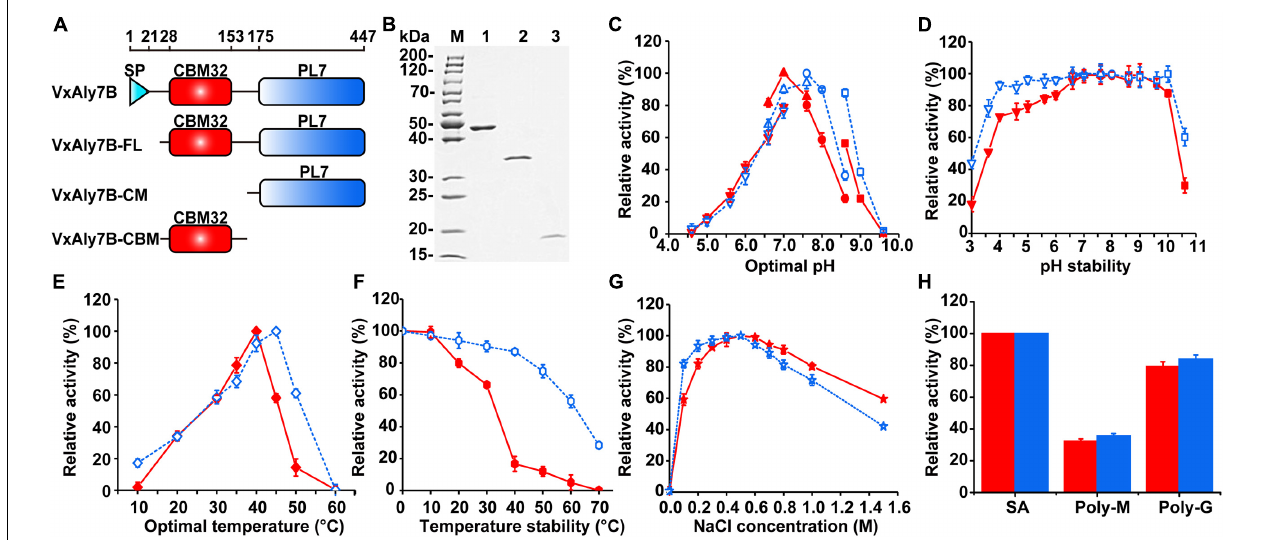
FIGURE 2 | Purification and enzymatic characteristics of recombinant VxAly7B and its truncated mutants. (A) Domain structure of full long VxAly7B and its two truncated mutants. (B) Purified recombinant VxAly7B-FL, VxAly7B-CM, and VxAly7B-CBM were resolved by SDS-PAGE. Lane M, molecular weight markers; Lane 1, purified recombinant VxAly7B-FL; Lane 2, recombinant VxAly7B-CM; Lane 3, recombinant VxAly7B-CBM. (C) Optimum pH for recombinant VxAly7B-FL and VxAly7B-CM were determined by measuring the activity at 40 or 45 ◦ C in 50 mM Na 2 HPO 4 -citric acid buffer (pH 4.6–7.0, inverted triangles), 50 mM Na 2 HPO 4 -NaH 2 PO 4 buffer (pH 6.6–7.6, regular triangles), 50 mM Tris-HCl buffer (pH 7.6–8.6, circles) and 50 mM Gly-NaOH buffer (pH 8.6–9.6, squares). The red line represented the recombinant VxAly7B-FL, and the blue line represented the recombinant VxAly7B-CM. (D) To determine pH stability, the residual activity of recombinant VxAly7B-FL and VxAly7B-CM were measured at 40 or 45 ◦ C in 20 mM Na 2 HPO 4 -NaH 2 PO 4 buffer (pH 7.0) and Tris-HCl buffer (pH 7.6) after incubation in 50 mM Na 2 HPO 4 -citric acid buffer (pH 3.0–7.0, inverted triangles), 50 mM Na 2 HPO 4 -NaH 2 PO 4 buffer (pH 6.6–7.3, regular triangles), 50 mM Tris-HCl buffer (pH 7.6–8.6, circles) and 50 mM Gly-NaOH buffer (pH 8.6–10.6, squares) at 4 ◦ C for 12 h, respectively. (E) Optimal temperature for recombinant VxAly7B-FL and